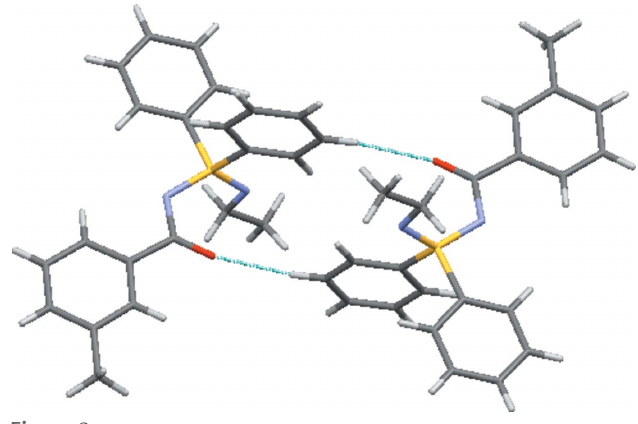
(16) ring motif (S1-containing 2